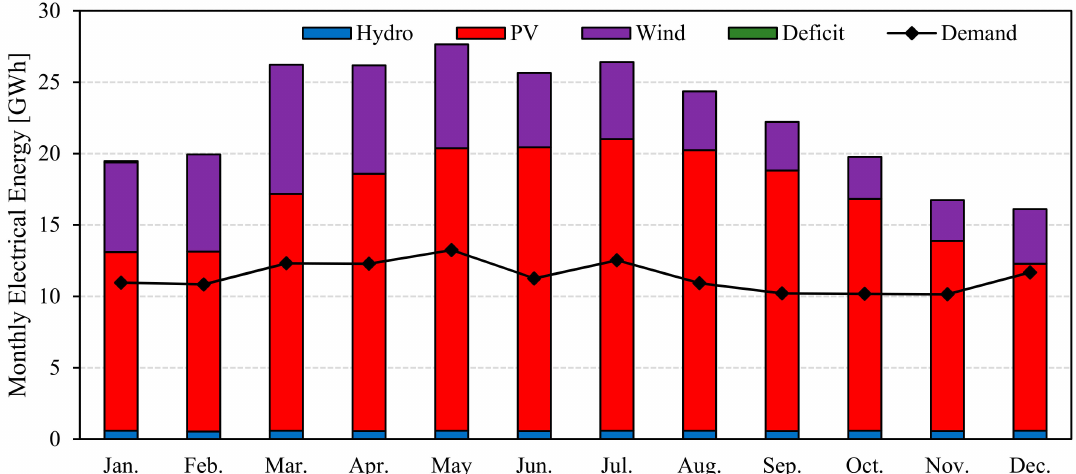
Figure 8. Monthly energy generation by the RES components with ESS (LCOE of 0.165 $ /